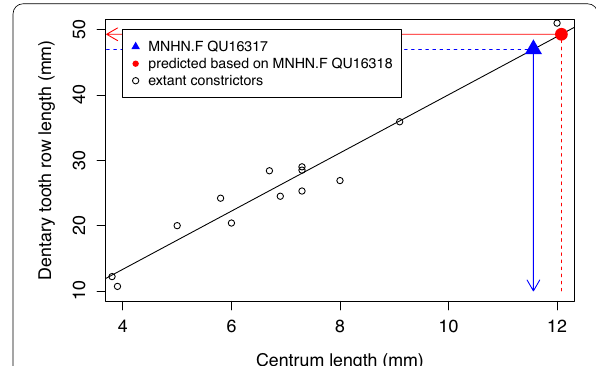
Fig. 16 Relationship between dentary tooth row length and mid-trunk vertebral centrum length (CL) in extant Constrictores. Centrum length indicated by paralectotype dentary of Palaeopython cadurcensis (MNHN.F QU16317) and dentary tooth row length indicated by vertebra in lectotype of Palaeopython cadurcensis (MNHN.F QU16318) support the referral of the paralectotype dentary based on size (and by implication, the paralectotype maxilla, MNHN.F